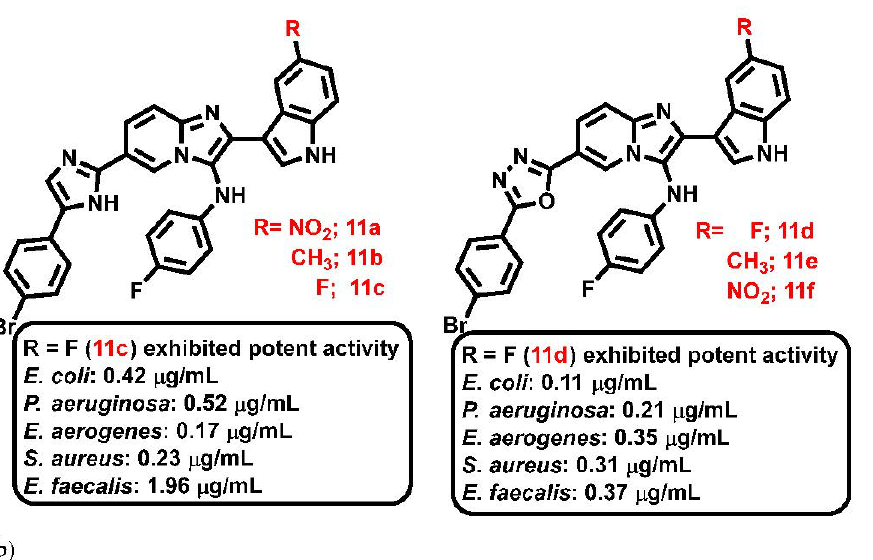
Figure 12. ( a ) General scheme for the synthesis of novel indole-based imidazopyridine derivatives. Signatures of compounds according to Al-Tel et al., 2011 [66]. ( b ) Indole-based imidazopyridine derivative exhibiting activity against different selected strains. Signatures of compounds according to Al-Tel et al., 2011 [66].